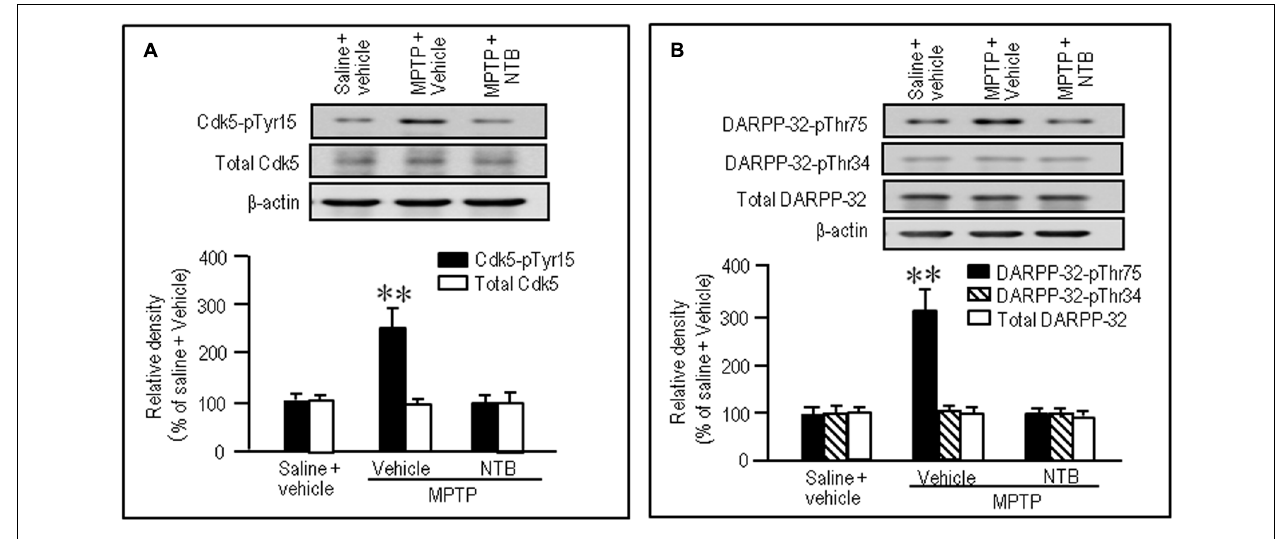
FIGURE 6 | Nilotinib affects striatal phosphorylation of Cdk5 and DARPP-32 in MPTP mice. Saline- or MPTP-treated mice were administered vehicle or nilotinib (NTB; 25 mg/kg) 30 min before they were sacrificed. Striatal tissue extracts were prepared and subjected to western blotting. (A) Western blot analysis of striatal levels of Cdk5 and Cdk5-pTyr15 in mice treated with saline + vehicle (control), MPTP + vehicle, or MPTP + NTB. Values are means ± SEM ( n = 5).